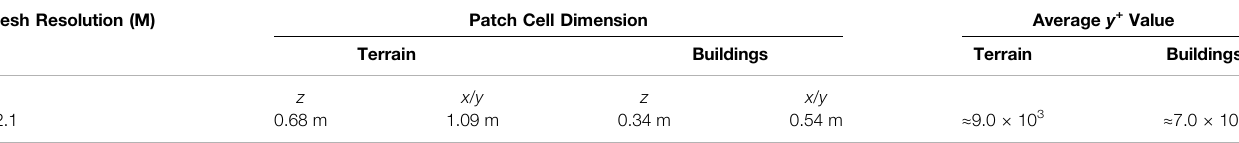
TABLE 1 | Key features of the mesh used. The reported cell dimensions correspond to the sizes at the surface of the patches. And at ground-level for the height of the cells adjacenttoapatch, z ,asthemeshisstretchedvertically.Thecell ’ slength, x ,andwidth, y ,remainconstant.Here,the x / y columnsdonotrepresentaratiobutthecellsize in both horizontal directions as they are identical for each re fi nement level.